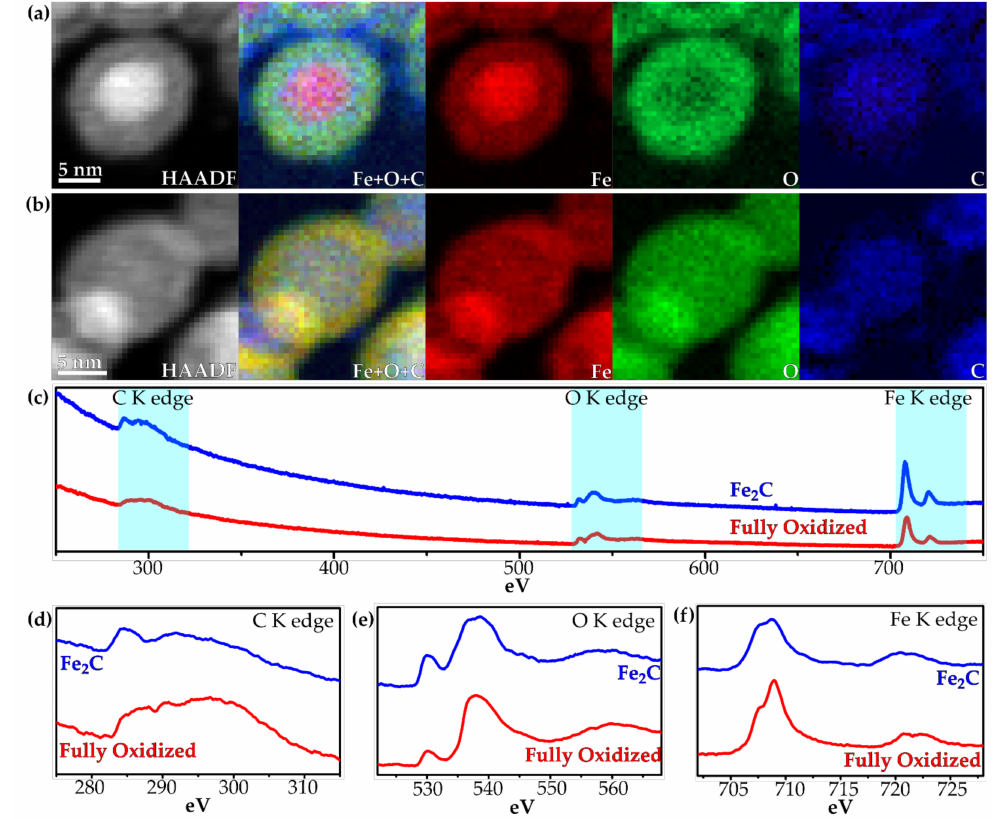
Figure 6. EELS spectrum image maps of ( a ) the Fe 2 C and ( b ) the fully oxidized Fe 2 C, showing the HAADF, overlayed map, Fe, O and C. All maps were generated from the windows in the EELS spectra shown in ( c ). ( d – f ) High-resolution EELS spectra of the C K edge, O K edge and Fe K edge, respectively, of the Fe 2 C and fully oxidized